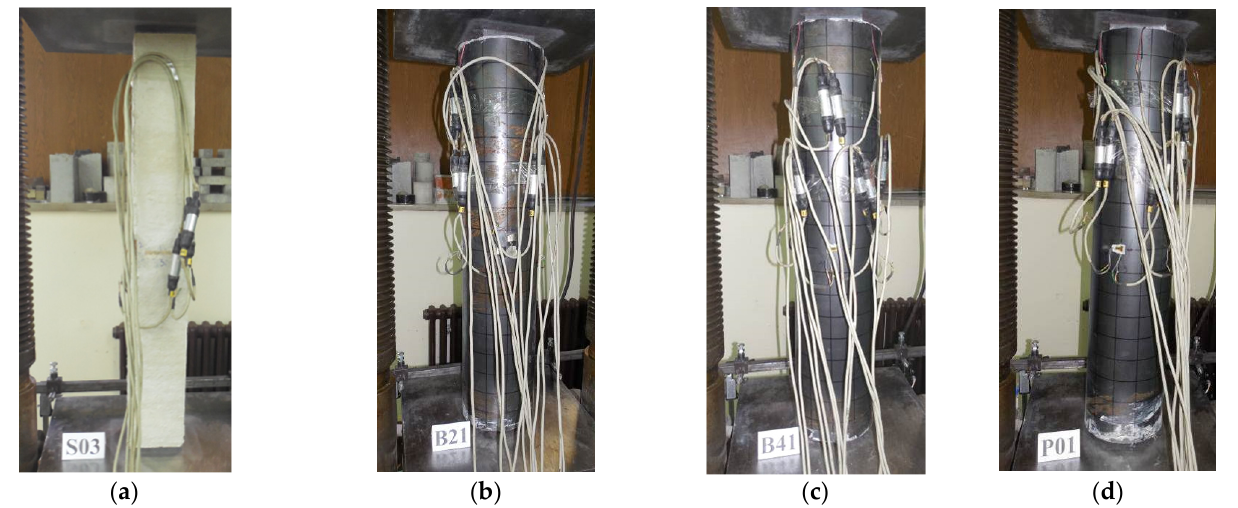
Figure 4. Column specimens before the experiment. Plain RC column ( a ) and strengthened columns ( b – d ).